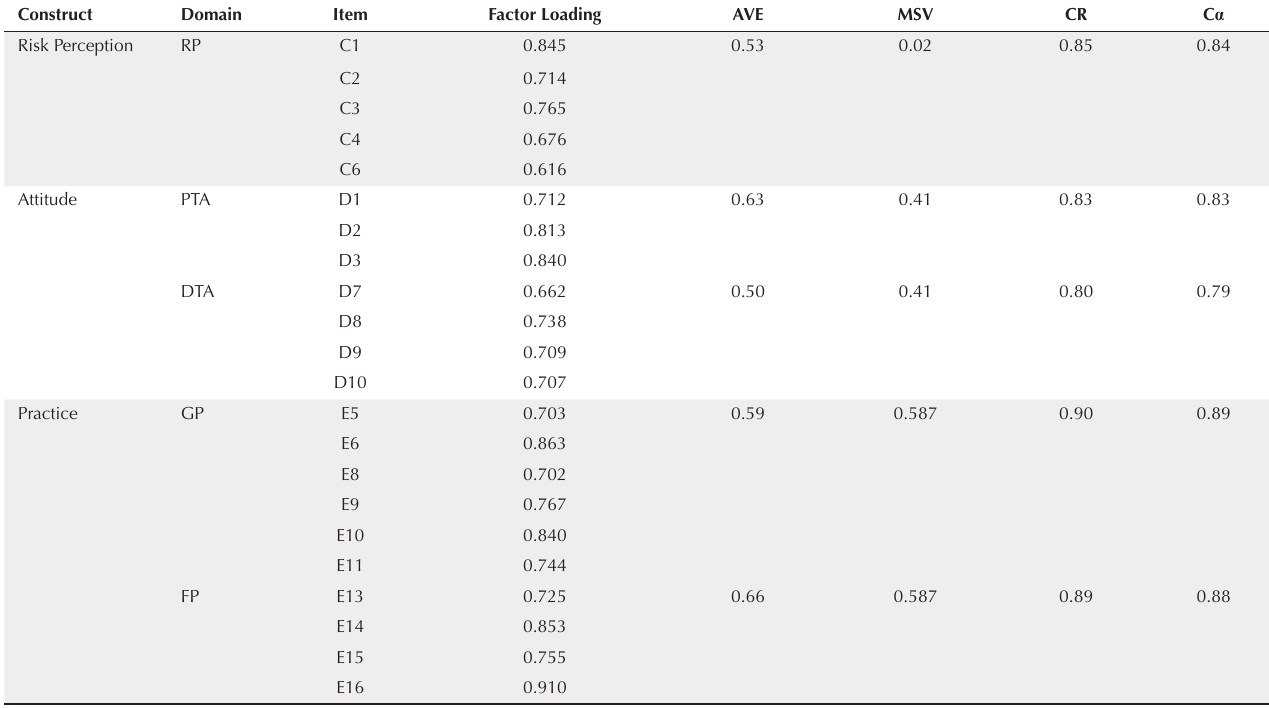
Table 3. CFA Results With Factor Loadings of Each Item Towards Their Respective Domains and the Measurement Index for Construct Validity and Internal Consistency